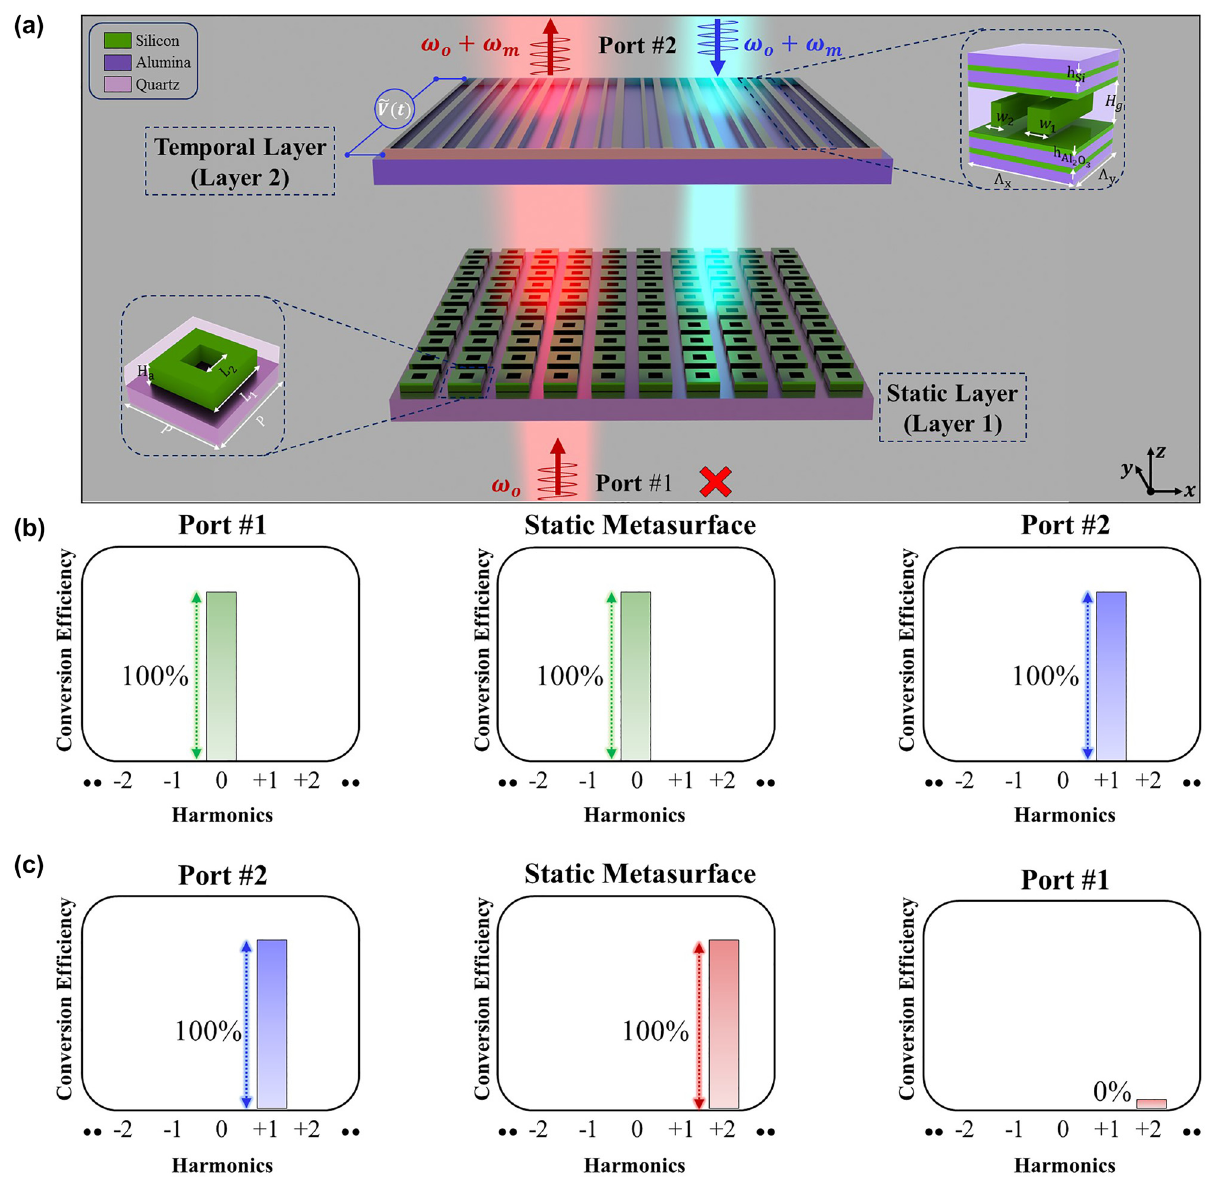
Figure 1: The nonreciprocity performance via transmissive metasurfaces. (a) The schematic depiction of the presented configuration that consists of two all-dielectric high-Q metasurfaces, which are under the illumination of an incident transverse electric (TE) polarized wave axis. The constituent elements of the first layer are subjected to a temporally varying bias voltage, with its electric field pointing toward ̂ e x while the second layer is a static super high-Q metasurface. (b) The spectral evolution of the transmitted light in the forward direction at three instants of times, namely, before and after interacting with the static metasurface (light green color) and after the interaction with the pure TMM (cyan color). It is clear that while the received signal undergoes the temporal photonic transition; its amplitude remains almost the same. (c) The spectral evolution of the transmitted light under time-reversal at three instants of times, before the interaction with the pure TMM (cyan color), after passing through the temporal platform, and before interacting with the static metasurface (red color). The transmitted signal to port 1 demonstrates negligible amplitude while its spectral content shifts to higher-order frequency harmonics. = 2 𝜋 f = 2 𝜋 f +∞ ∑ and 𝜔 are the optical and wherein 𝜔 ( ) m m o o 𝜓 + n 𝜔 ( t ) = exp ) t e ( t ) i ( 𝜔 modulation angular frequencies, respectively,  ( t ) and tra o m n n =−∞  ( t ) are the time-domain transmission and reflection ( ) = 𝜓 |  ( t ) | exp exp( i 𝜔 i ∠  ( t ) t ) (1) is the amplitude of incident field, coefficients, 𝜓 o o o